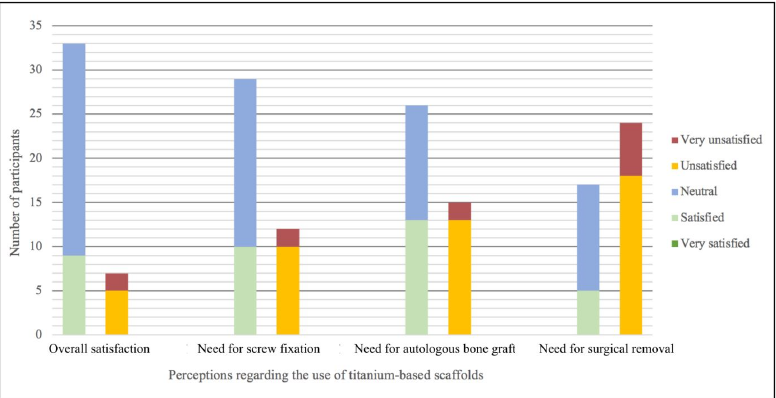
Figure 2. Participants’ satisfaction with various aspects of titanium-based scaffolds.